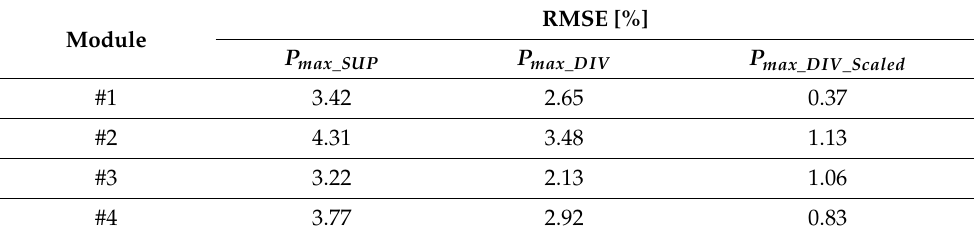
Table 2. Comparison of root-mean-square error (RMSE) between the STC measured P max , and the dark I-V estimated P max ( P max _ SUP – only shunting and J o 2 losses are estimated; P max _ DIV —series losses are estimated as well; P max _ DIV _ Scaled —other losses are estimated with a final STC power